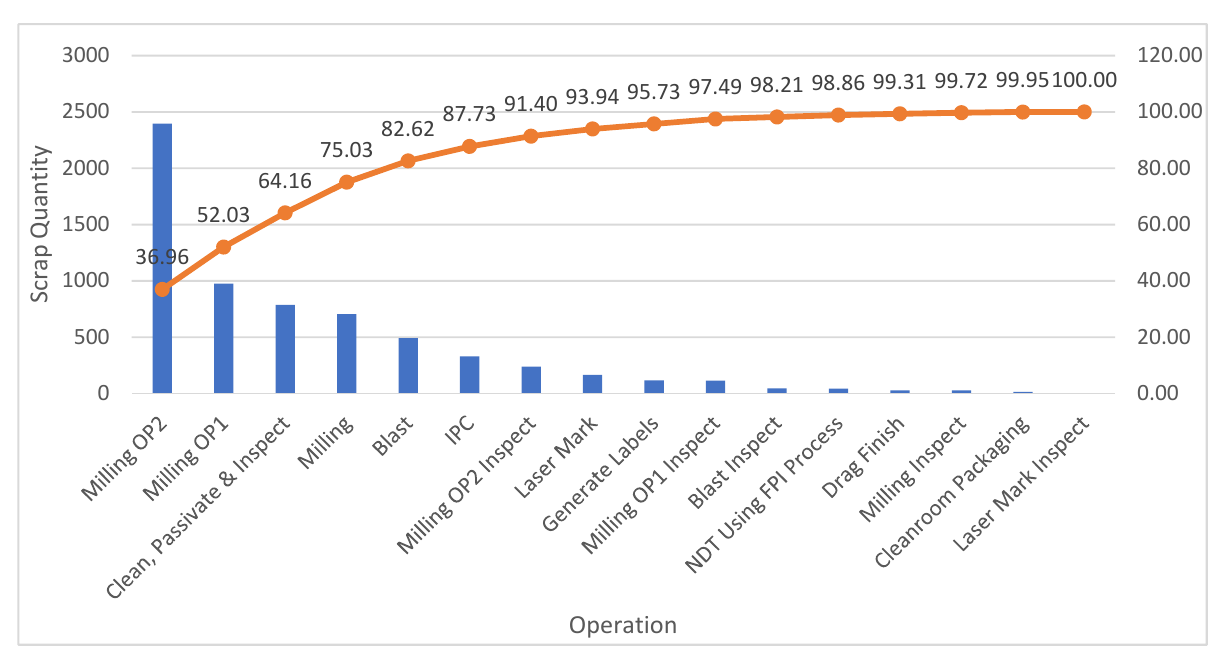
Figure 6. Process flowchart.